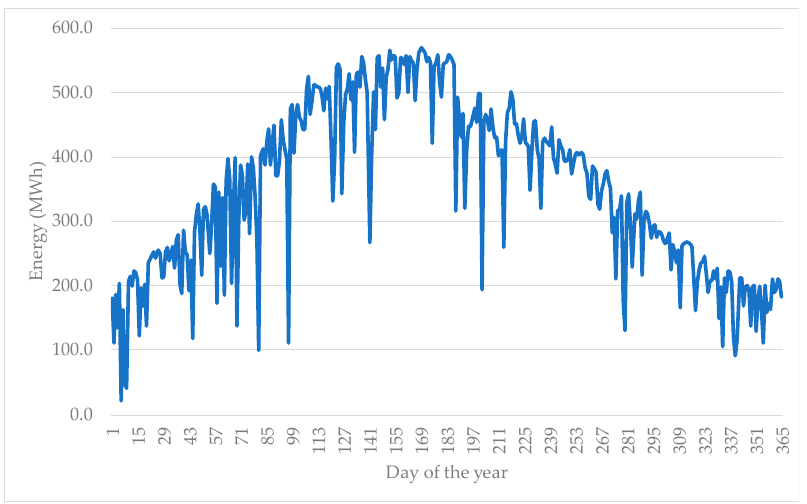
Figure 9. Daily energy production results using the temperature model proposed in this study for 10% coverage of Lake Mead’s surface.